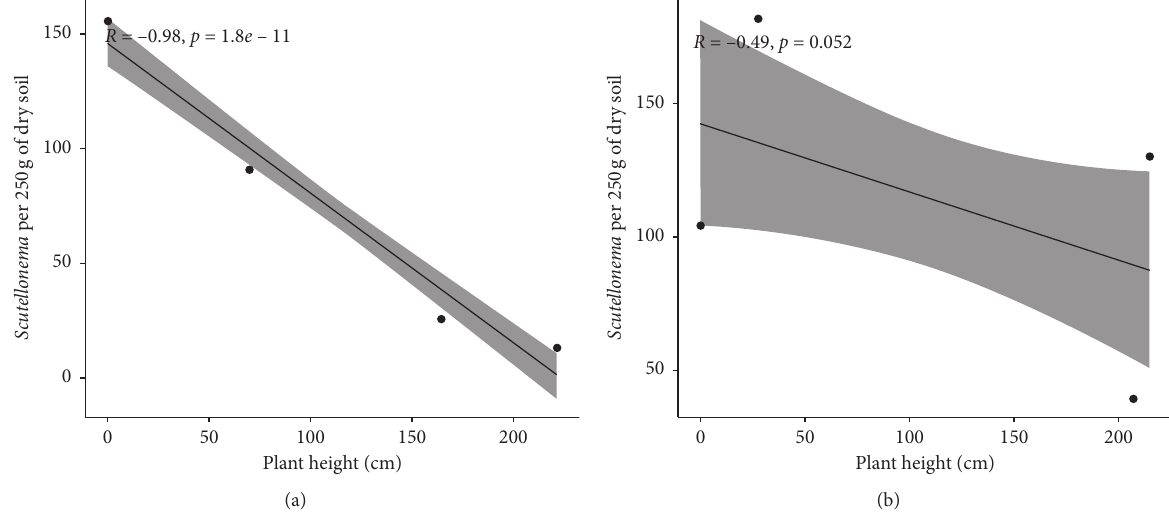
Figure 5: Correlation between plant height and Scutellonema density during 2018 (a) and 2019 (b) in control plots. The relationship for 2018 and 2019 showed a significant negative association ( R � − 0.98, p ≤ 0 . 001, and R �− 0.49, p � 0 . 052,